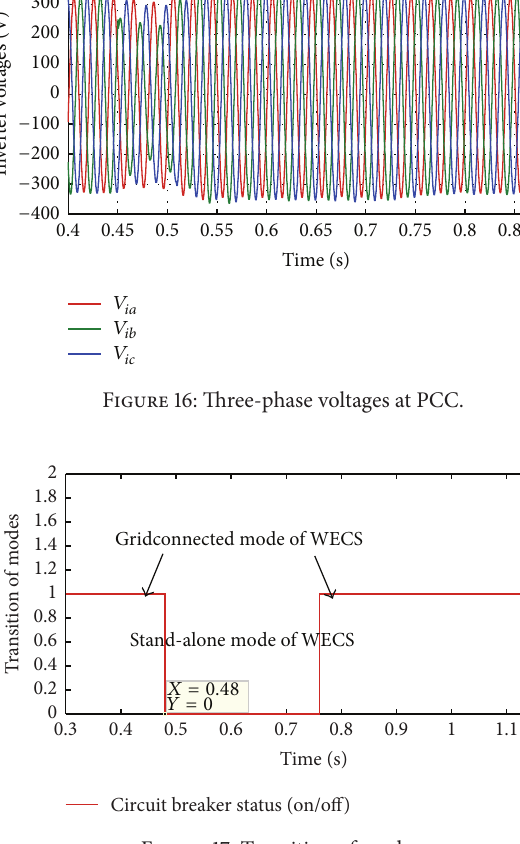
Figure 17: Transition of modes.